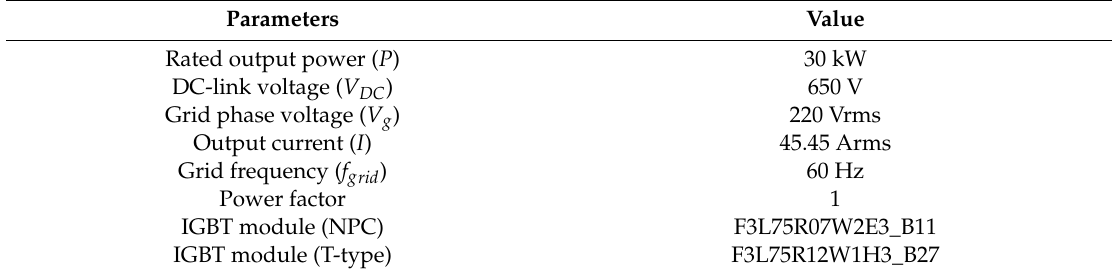
Table 1. Parameters for 30 kW photovoltaic (PV) inverter system. NPC: neutral-point clamped. Parameters